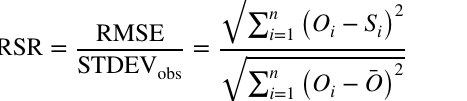
Table 3 General performance ratings for recommended statistics